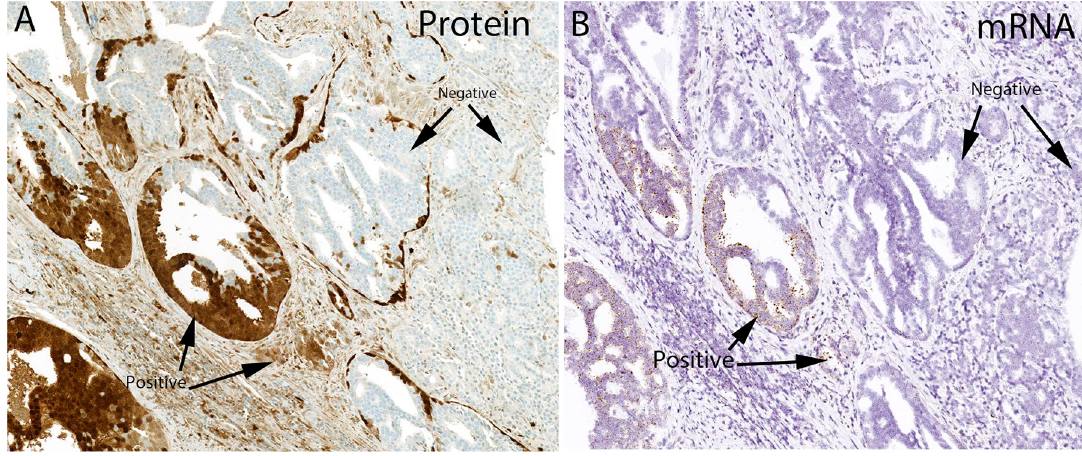
Fig 3. Concordance between in situ hybridization and IHC for GSTP1 in a heterogeneous prostate cancer case.